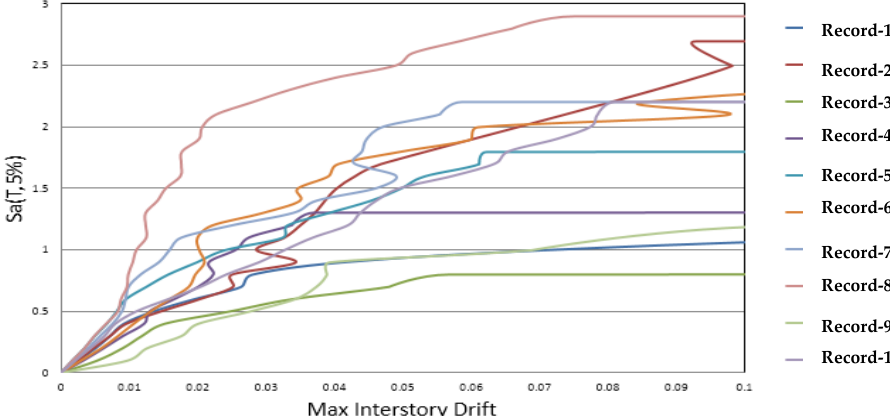
Figure 19. IDA curves obtained for a 3-story building with simple connections.